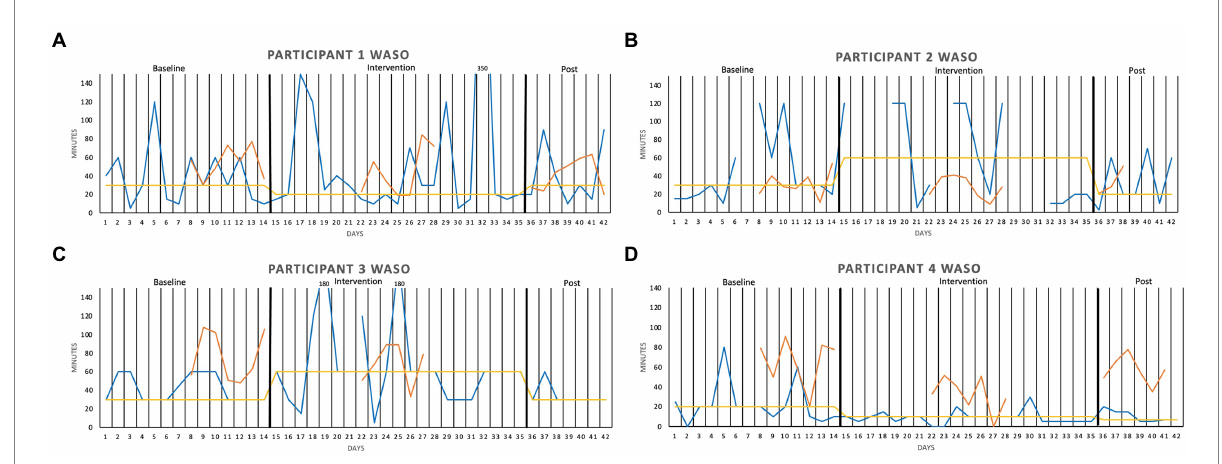
FIGURE 2 Wake After Sleep Onset (WASO, in minutes) measured over two baseline weeks, three intervention weeks, and 1 week post-intervention, for (A) Participant 1, (B) Participant 2, (C) Participant 3, and (D) Participant 4. The sleep diary is represented by the blue lines, the actigraphy by the orange lines, and the median of each phase by the yellow lines.